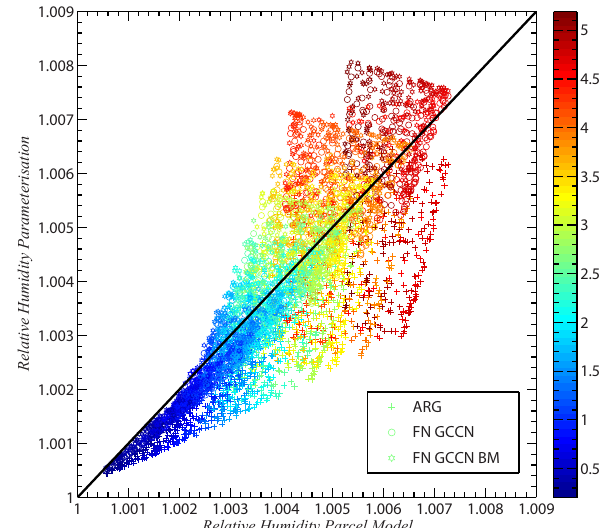
Figure 4. Results from 100 runs with bimodal aerosol size distribu- tions, 500cm − 3 in the first mode and 100cm − 3 in the second and a run time of 8000s. Only the median diameter of the aerosol in the second mode and the updraft velocity were changed between runs, within the ranges of 550 ≤ d m ≤ 800nm and 0.2 ≤ w ≤ 0.5ms − 1 respectively. Symbols are coloured by median diameter (nm) of the second mode, see colour bar. For initial conditions see Table 1.